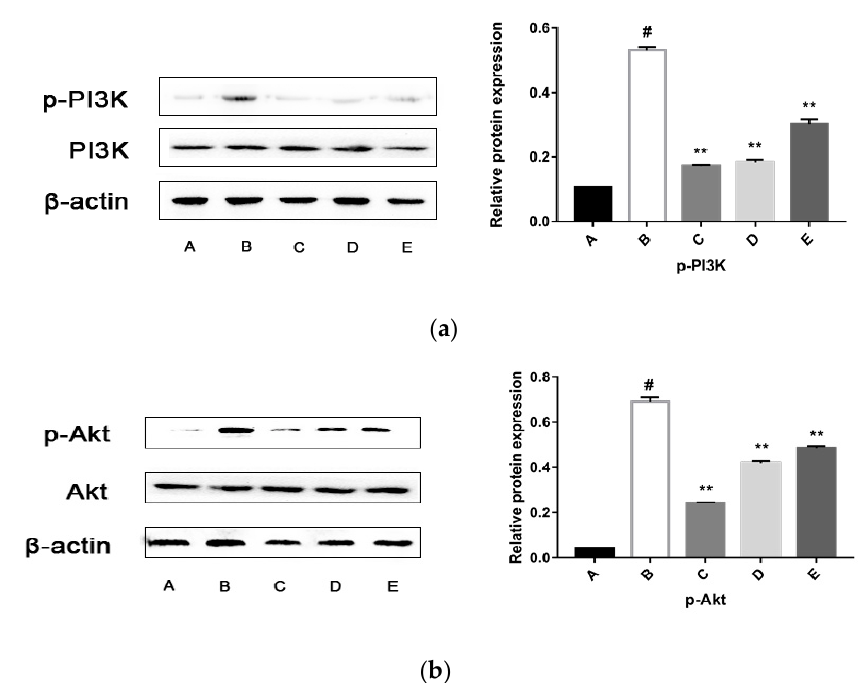
Figure 7. Effects of the CPhG liposomes on the expressions of p-PI3K, PI3K, p-Akt, and Akt in HSCs. ( a ) The protein expression of p-PI3K and PI3K. ( b ) The protein expression of p-Akt and Akt. A, the Control group; B, the rrPDGF-BB treated group; C, the rrPDGF-BB + CPhG liposome 29.45 µg/mL treated group; D, the rrPDGF-BB + CPhG liposomes 14.72 µg/mL treated group; E, the rrPDGF-BB + CPhG liposomes 7.36 µg/mL treated group; Data are expressed as the mean ± SD. ** p < 0.01, significantly different compared with the rrPDGF-BB-activated HSC group. # p < 0.05, significantly different compared with the control group. β -actin was used as an internal control.